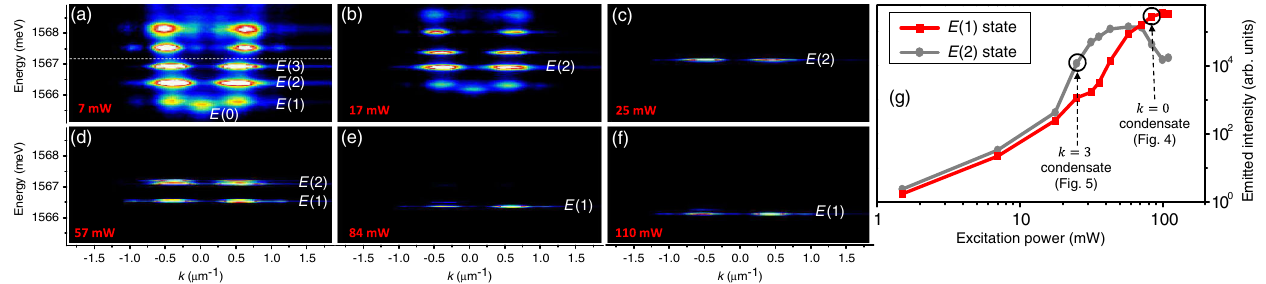
FIG. 3. Power dependence of the condensation process. (a) – (f) Energy- and momentum-resolved emission of the molecule as a function of the excitation power, indicated in each panel. At low power (a), the E ð 0 Þ ; … ; E ð 3 Þ energy levels are visible along with higher energy states (above the dashed line) arising from the coupling of higher energy modes of each individual pillar [32]. When increasing the excitation power, polariton condensation occurs first in one of the states of the multiplet E ð 2 Þ (c) and then in one of the states of the multiplet E ð 1 Þ (e,f). In (d), the double line in E ð 2 Þ arises from fluctuations in the position of the pump spot during the measurement (see Sec. E of Ref. [32]). These fluctuations were absent in the experiments shown in Figs. 4 and 5. (g) Emitted intensity of the E ð 1 Þ and E ð 2 Þ states as a function of the excitation power. The circles indicate the power at which the experiments shown in Figs. 4 and 5 were